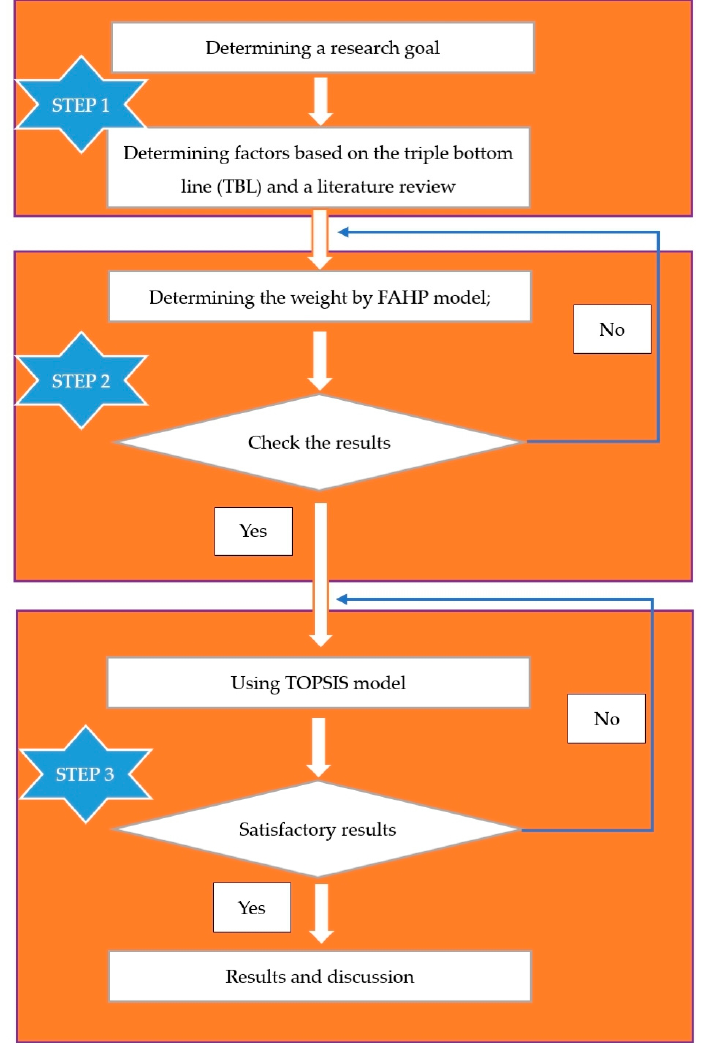
Figure 1. Research graph. FAHP—fuzzy analytic hierarchy process; TOPSIS—technique for order of preference by similarity to an ideal solution.